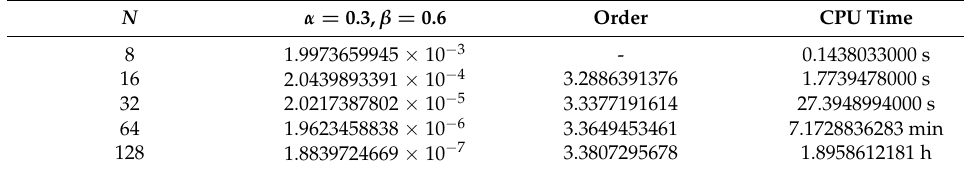
Table 1. Maximum errors, decay rate and CPU time with M = 2 N . N α = 0.3, β = 0.6